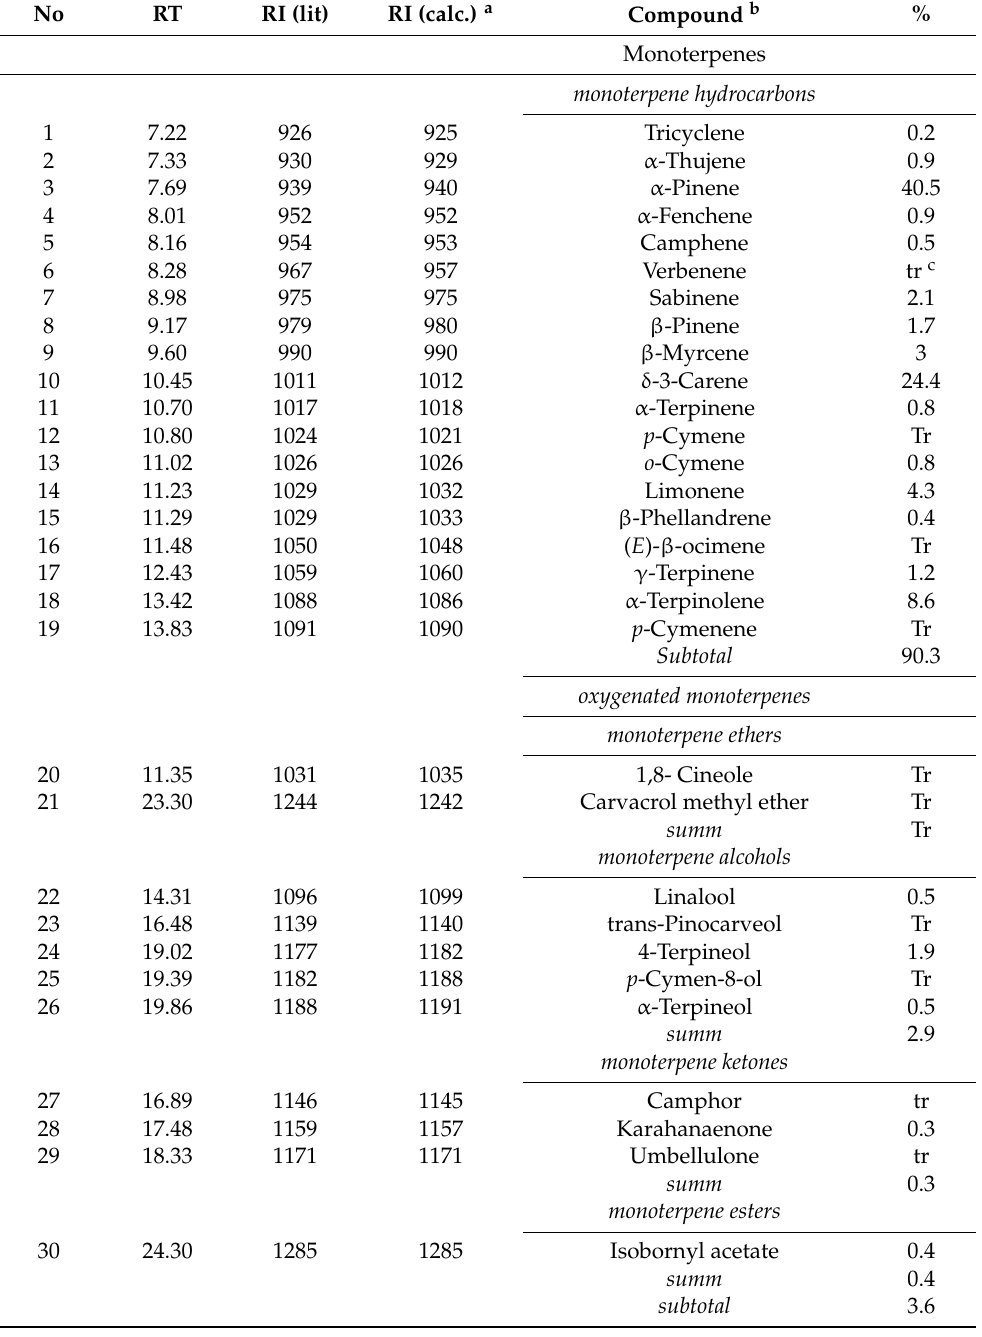
Table 1. Chemical composition of